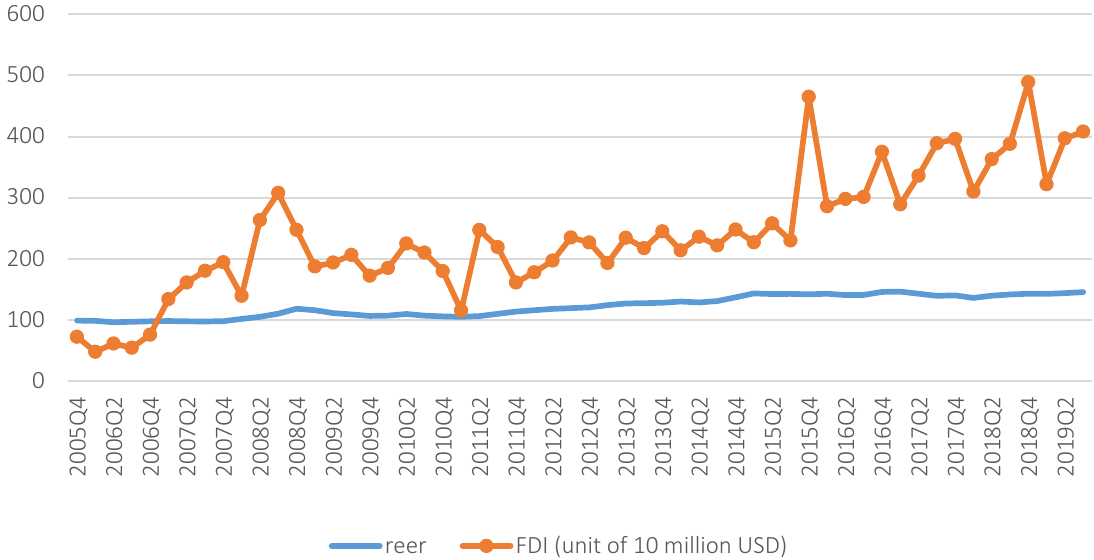
Figure 3. The relationship between REER and FDI inflows in